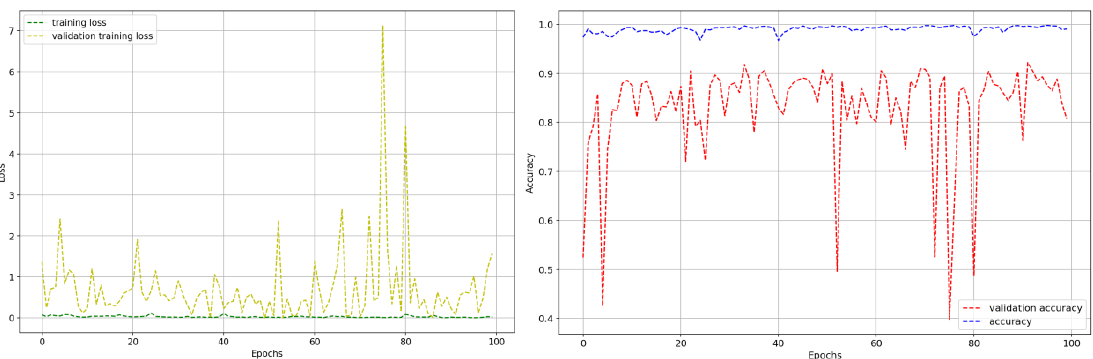
Figure 10. Training/testing loss and accuracy of the proposed pruned deep convolutional neural network. Table 4 has the experimental results to prove the assumptions above. The whole worst scored 20 filters and node weights after can been seen in Table 4. The first hidden layers have different nodes.